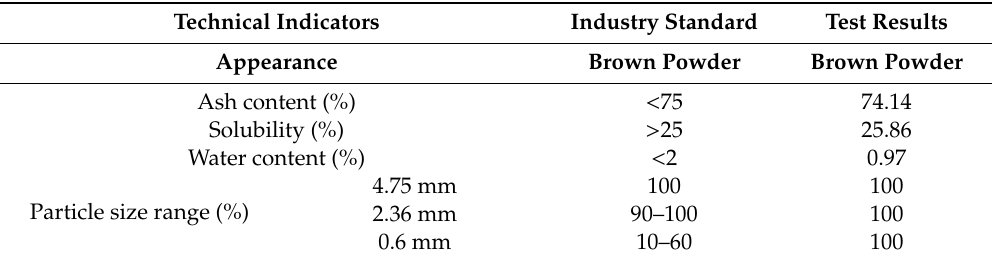
Table 2. Main technical indexes of Buton rock asphalt.